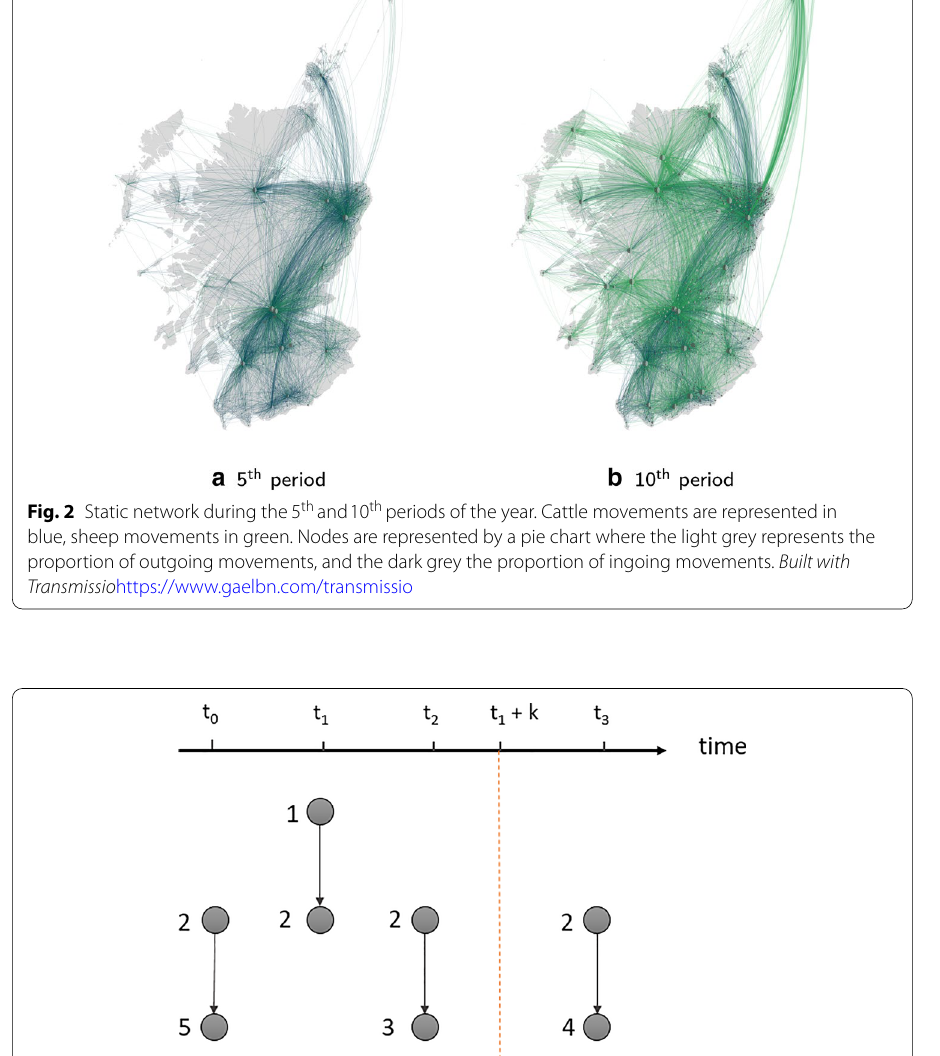
t 0 < 28 days, node 1 and −